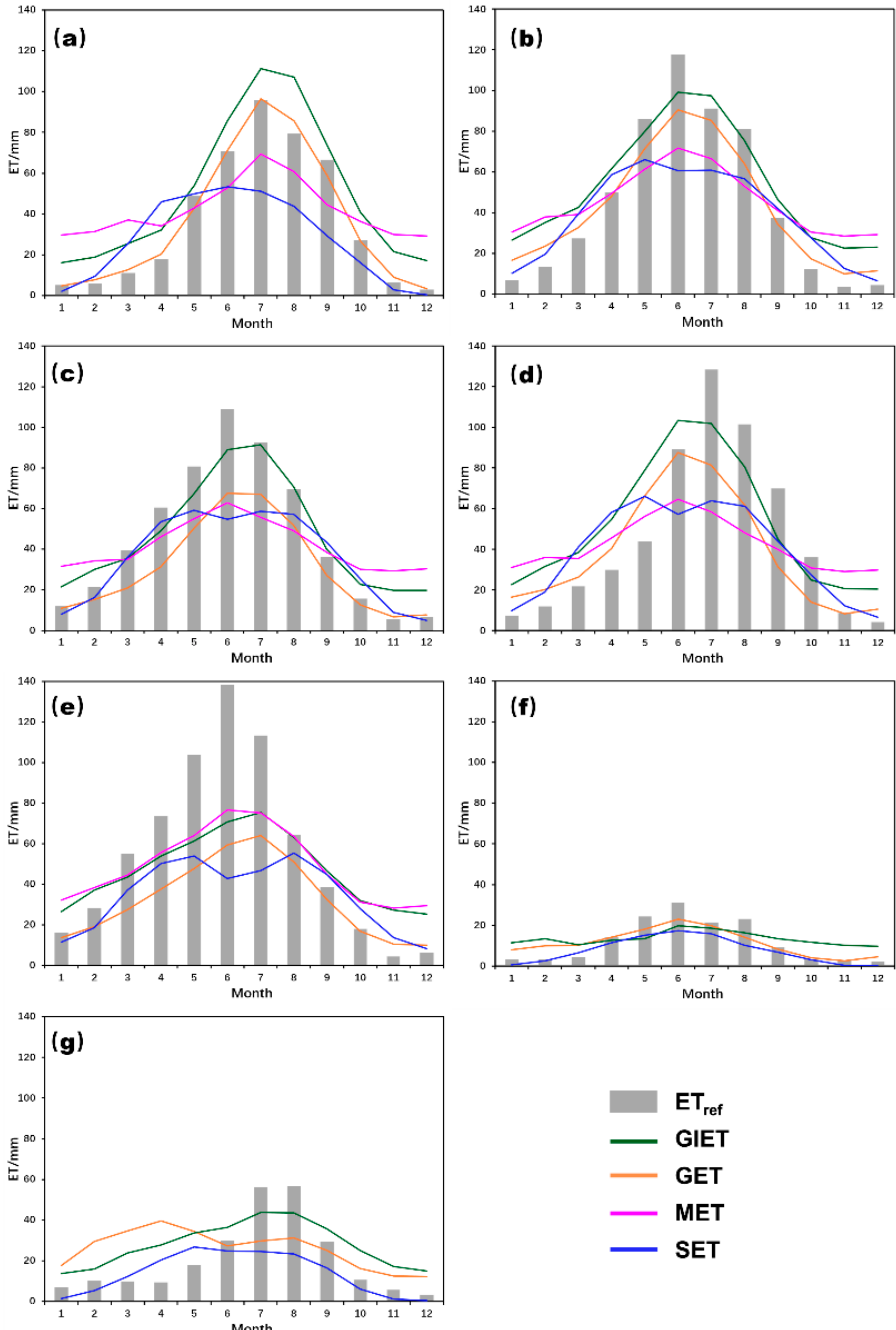
Figure 7. Seasonal variations of the ET ref (mm) and the ET products (mm) in the seven sub-basins averaged during 2003–2014. ( a ) Yellow River source region; ( b ) Yangtze River source region; ( c ) Salween River source region; ( d ) Mekong source region; ( e ) Yarlung Zangbo Basin; ( f ) Qaidam Basin; and( g ) Inner Plateau.